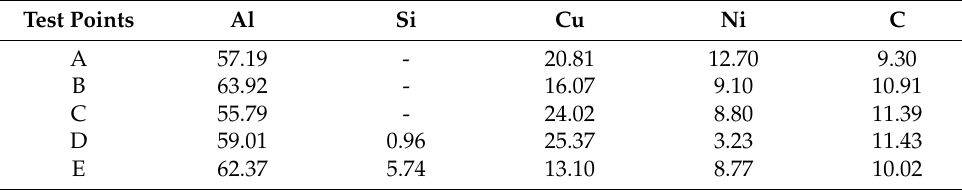
Table 3. Chemical compositions (at.%) of points marked in Figure